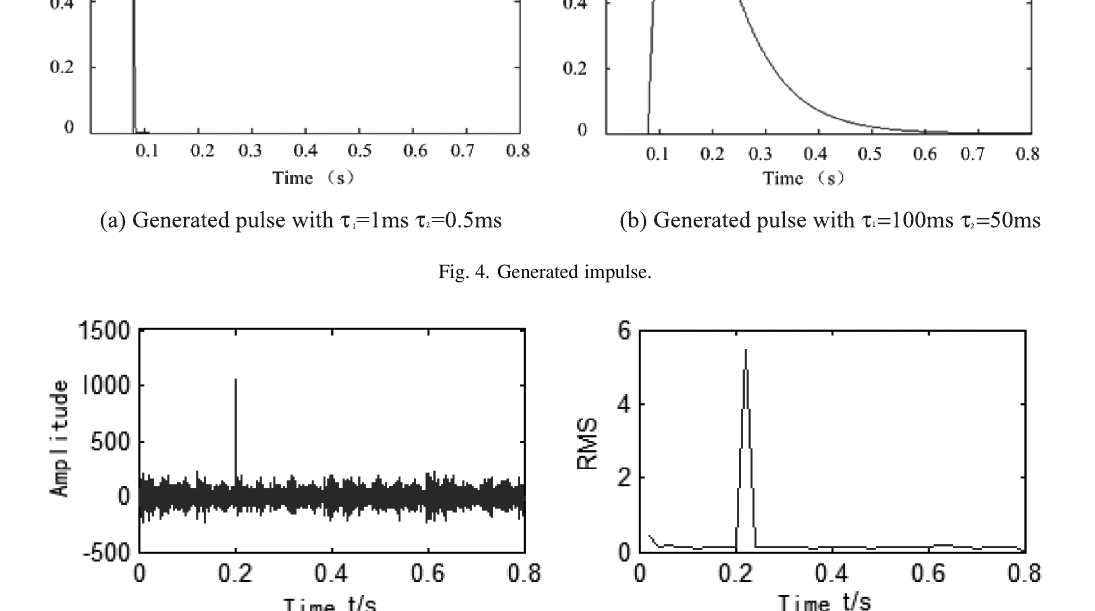
Fig. 5. Process result of signal with